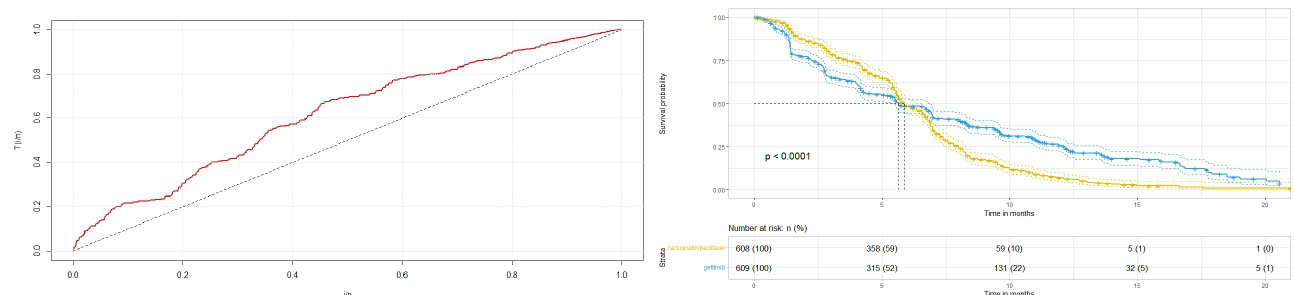
Figure 2. Illustrating the total time on test (TTT) plot, and the crossing survival curves for the two types of drugs determined using the Kaplan-Meier method for the IPASS